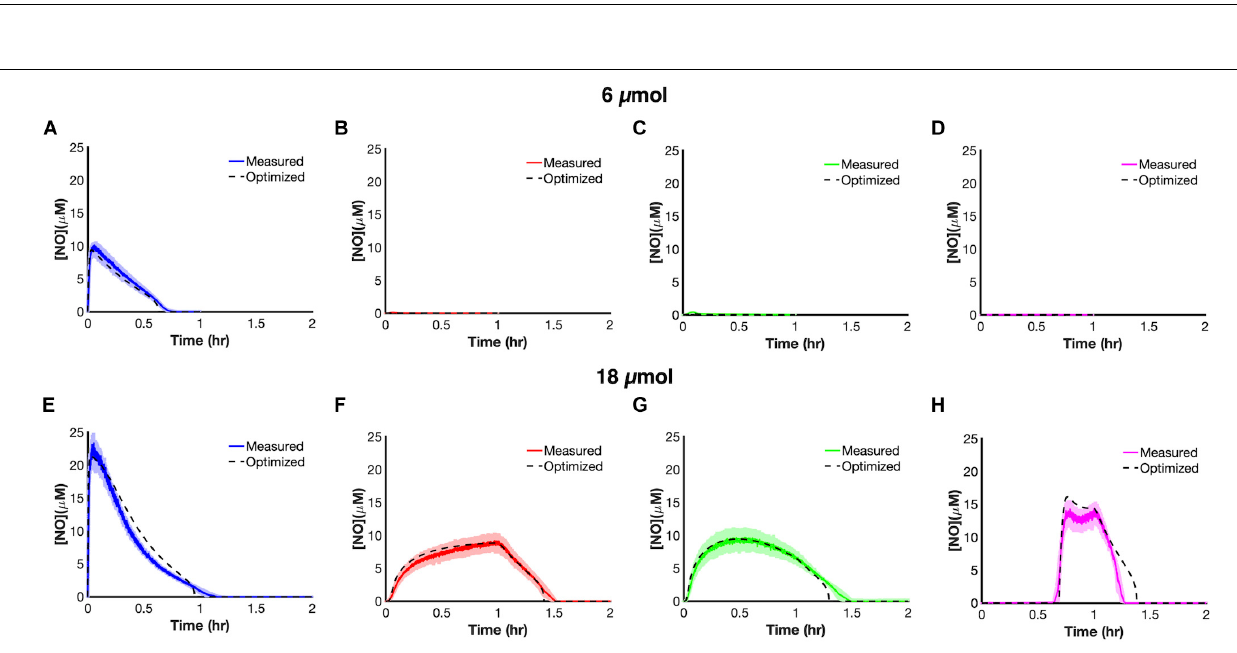
Frontiers in Physiology |